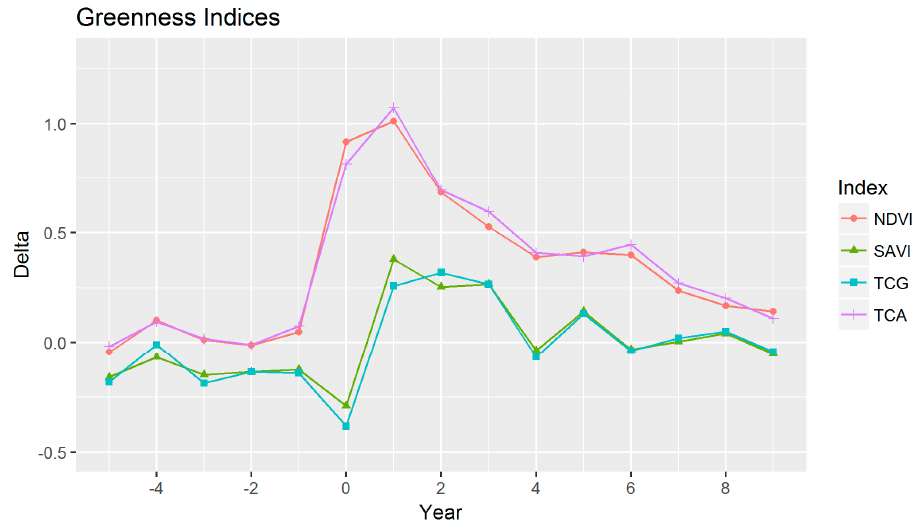
Figure 7. Mean values of textural variation for greenness indices from five years prior to fire to nine years post-fire.